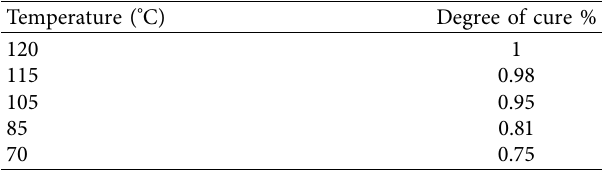
Figure 2: Changes of temperature and resistance curves in cooling stages at (a) 70 ° C and (b) 120 ° C. Table 1: Correlated changes in resistance for five curing